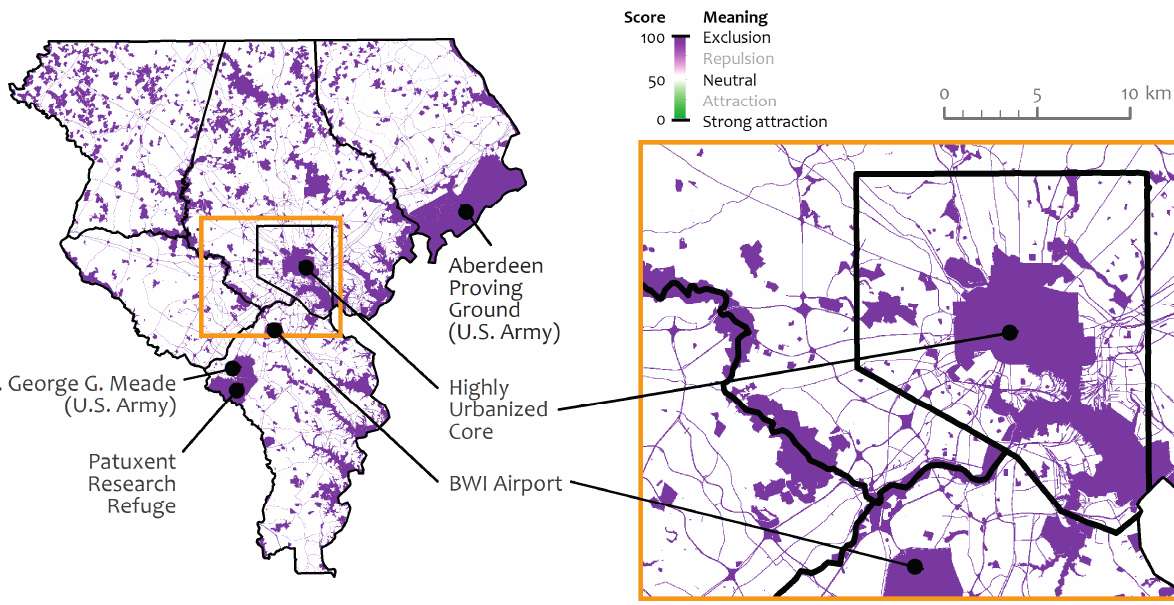
Figure 3. The exclusion/attraction layer used to guide the initial instance of the BMR SLEUTH model.